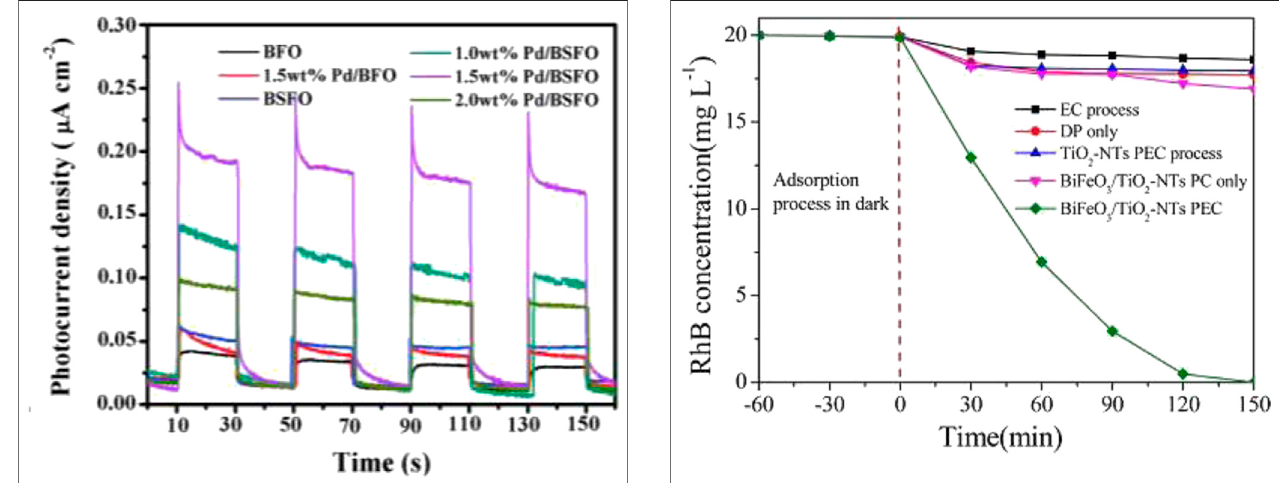
FIGURE 4 | Photocurrent action spectra of the prepared photocatalyst samples (Wang S. et al., 2016).